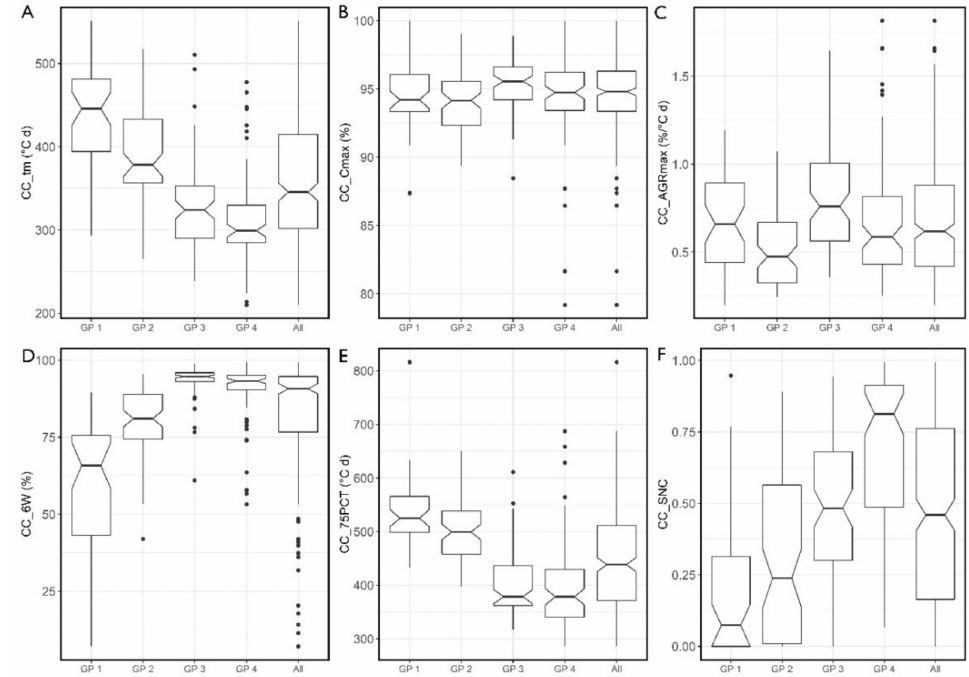
◦ C d) this resulted in a range ◦ C d) from 901 to 1312.